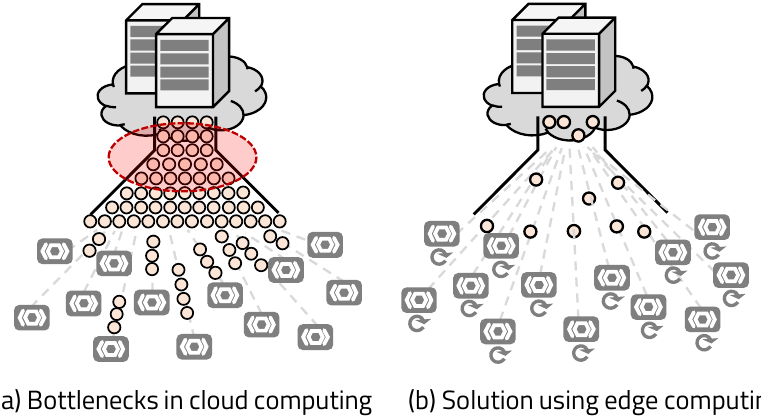
Figure 1. Cloud platform’s bottleneck